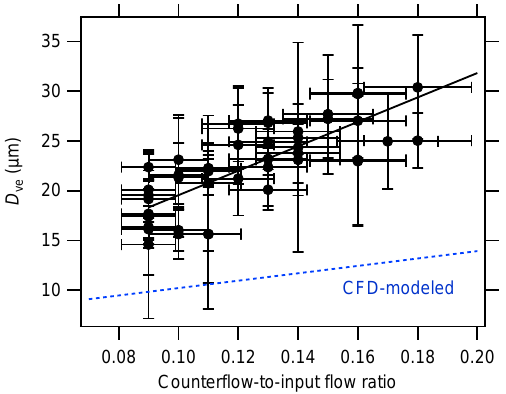
Figure 9. Ice particle cut-size spectrum as a function of the CF-to- IF ratio. During our validation tests, we systematically varied the IS-PCVI flow conditions (Table